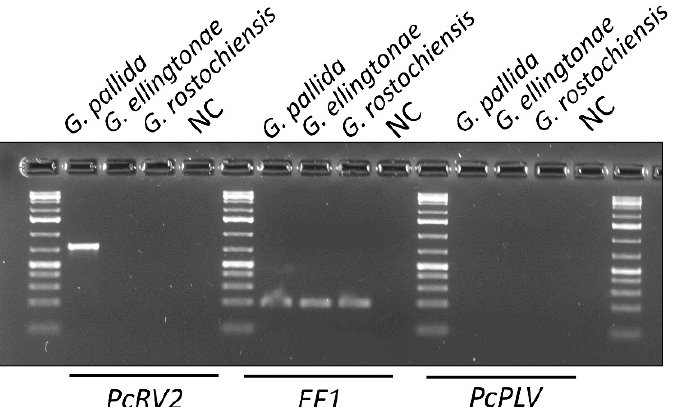
Figure 5. Detection of potato cyst nematode rhabdovirus (PcRV) and potato cyst nematode picorna- like virus (PcPLV, MG550273) in Globodera spp. nematodes present in the US and reproducing on potatoes. RT-PCR using RNA isolated from 10 cysts ( G. pallida , G. ellingtonae , or G. rostochiensis ) as a template and PcRV- or PcPLV-specific primers (see Supplementary Table S1). Globodera EF1 gene was used as a positive control. NC—negative non-template